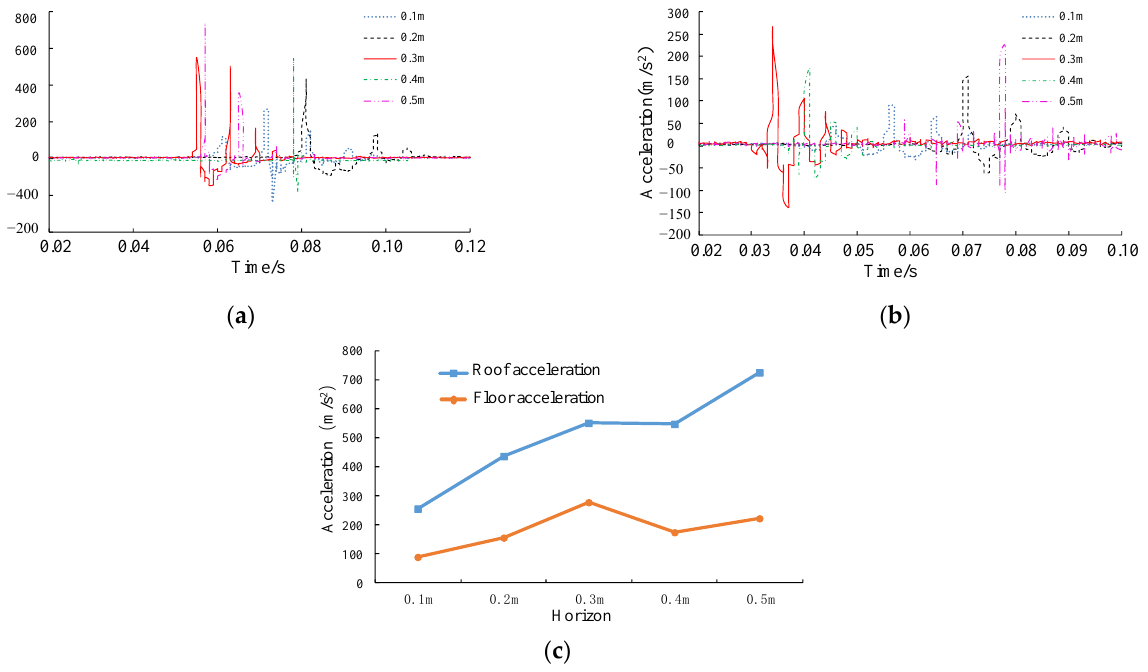
Figure 13. Acceleration response characteristics of coal and rock in the sixth layered test. ( a ) Acceleration at the roof of surrounding rock; ( b ) Acceleration at the floor of the roadway; ( c ) Peak acceleration at different energies.